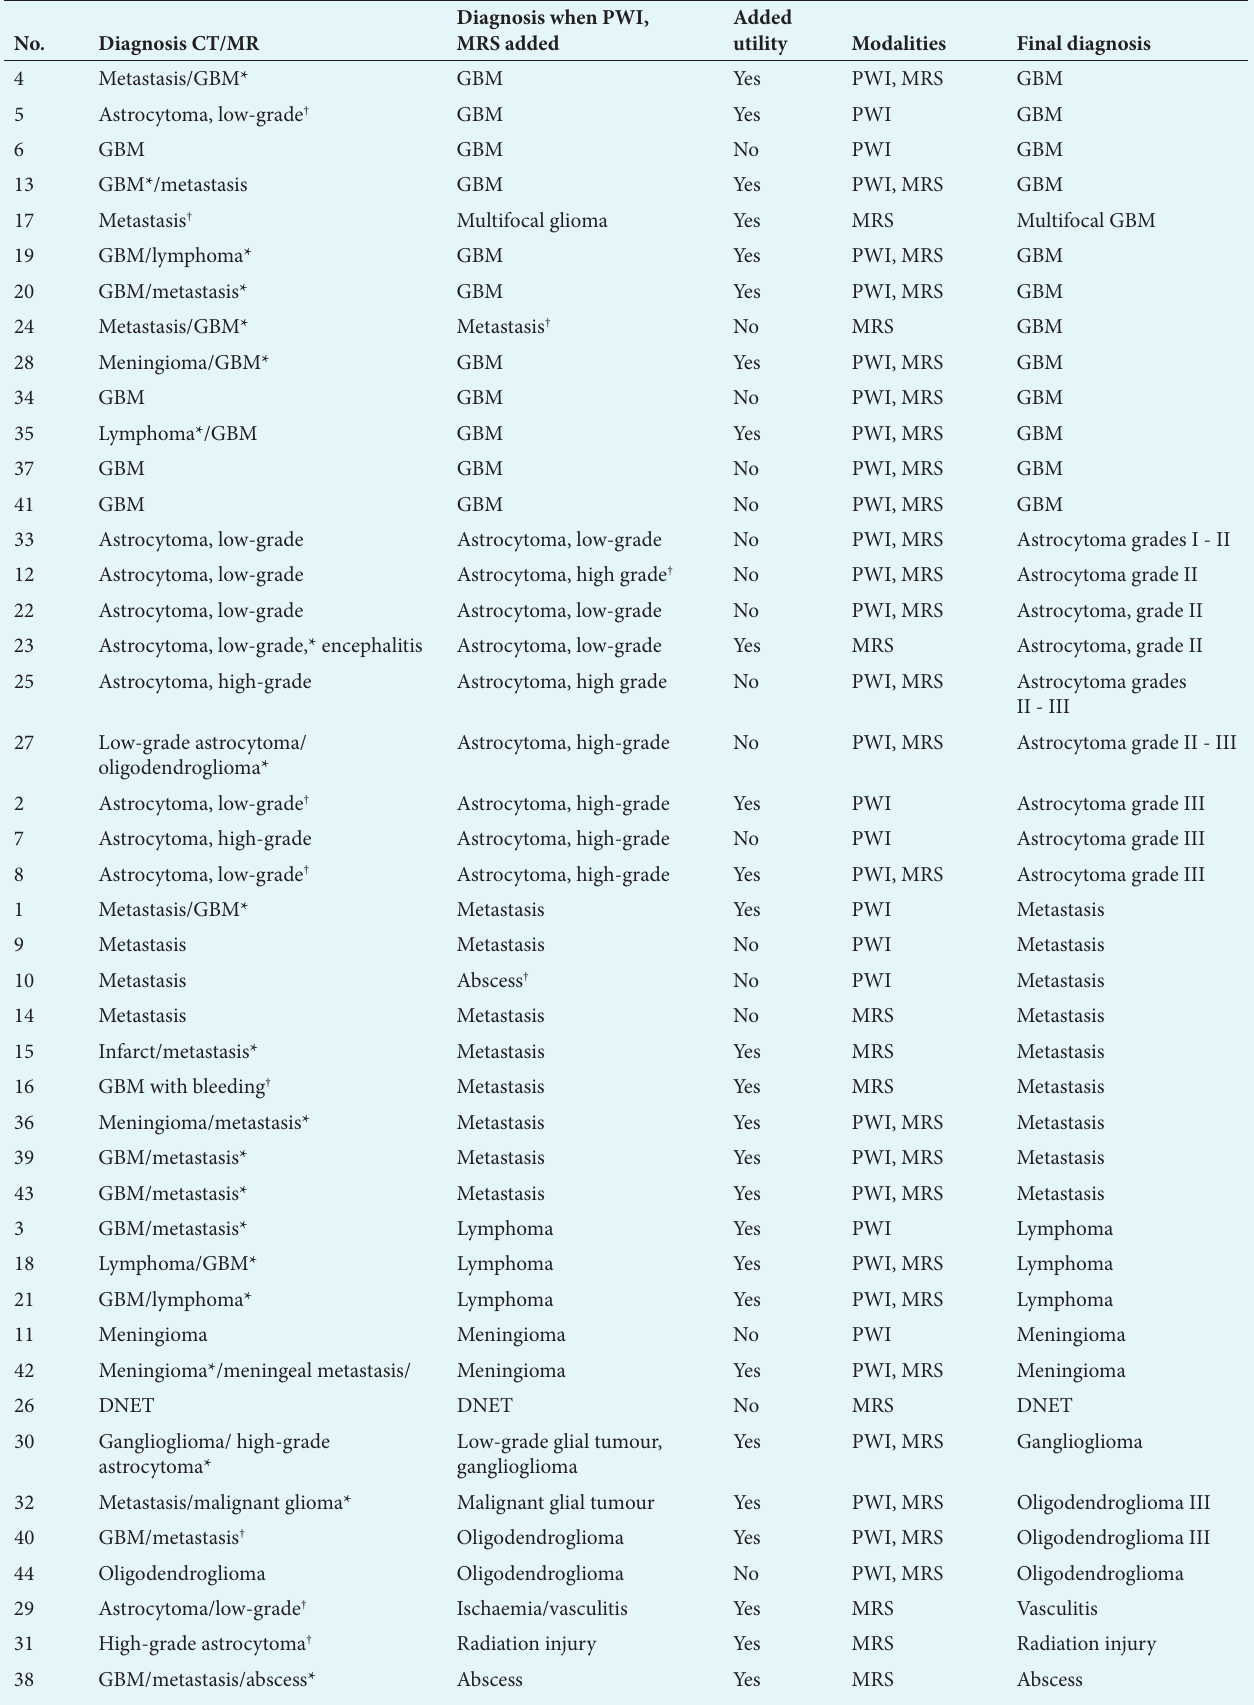
Table 1. Diagnosis given at the evaluation of conventional MR sequences, multimodal MRI and final diagnosis of the whole study